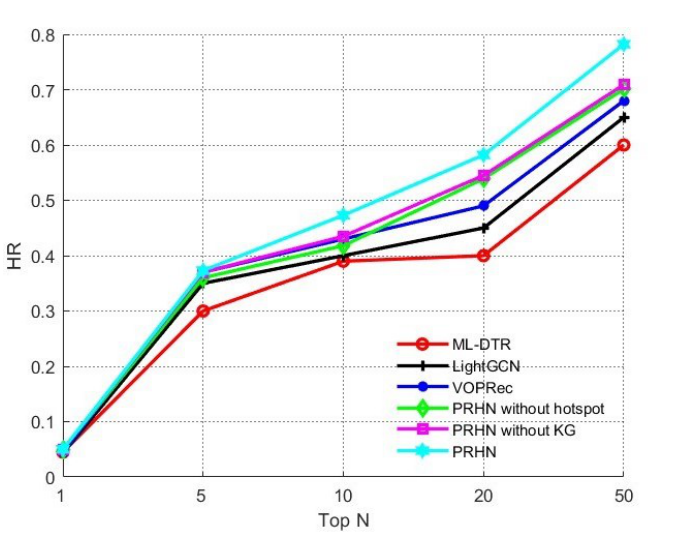
Figure 6. Performance metrics of HR for the three baseline models and our proposed model in metallurgical